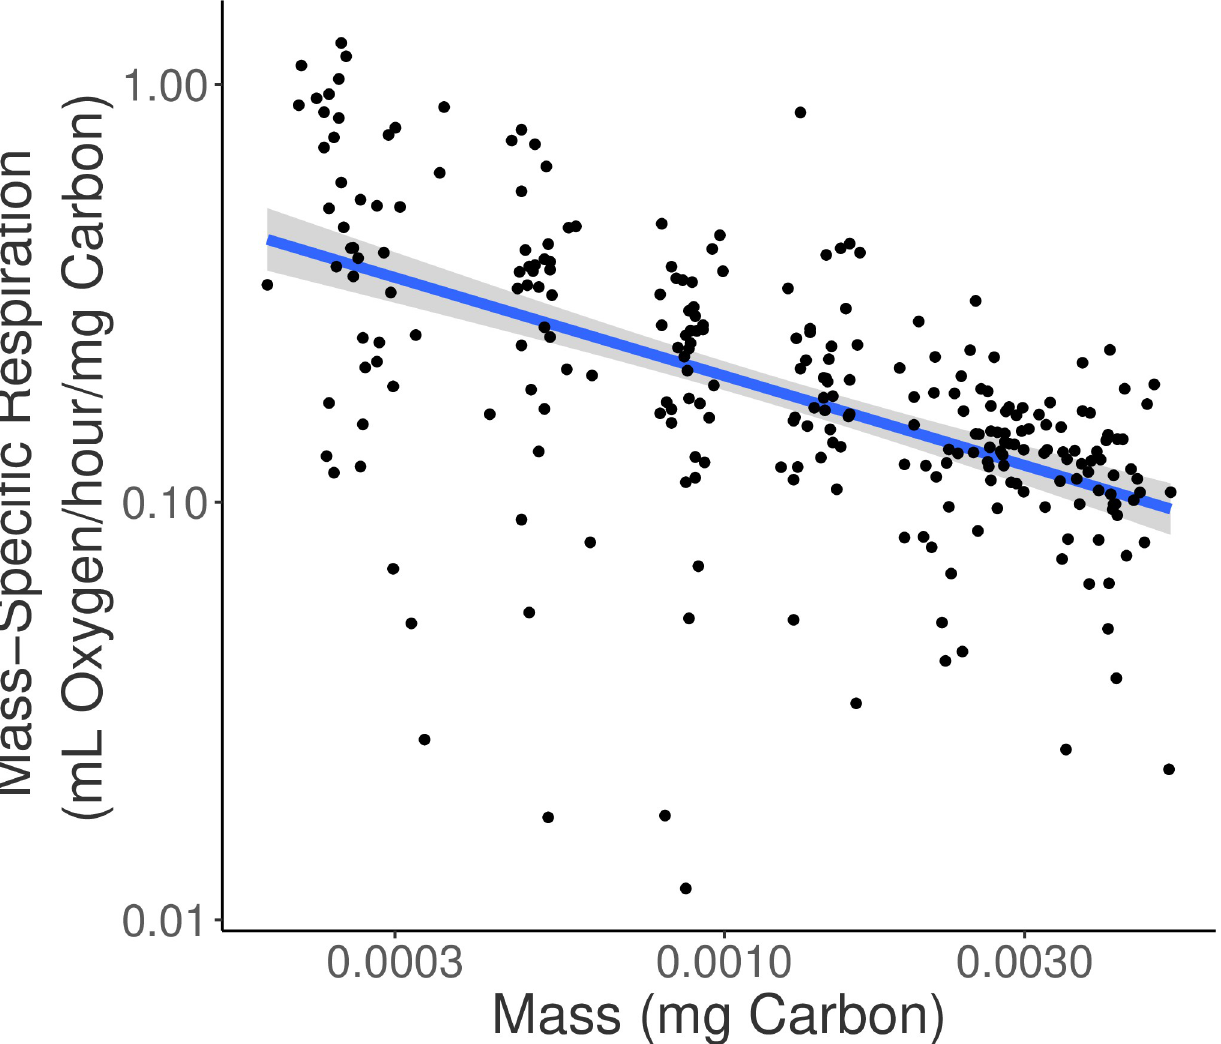
Fig 5. Relationship between mass-specific respiration (mL Oxygen/hour/mg carbon) and copepodite mass (mg Carbon). Scatter plot of log 10 mass- specific respiration (mL O 2 /hour/ng carbon) against mass (mg carbon). Log regression line is described by y = x -0.45 , r 2 = 0.31, p < 2.2 x 10 − 16 , n =